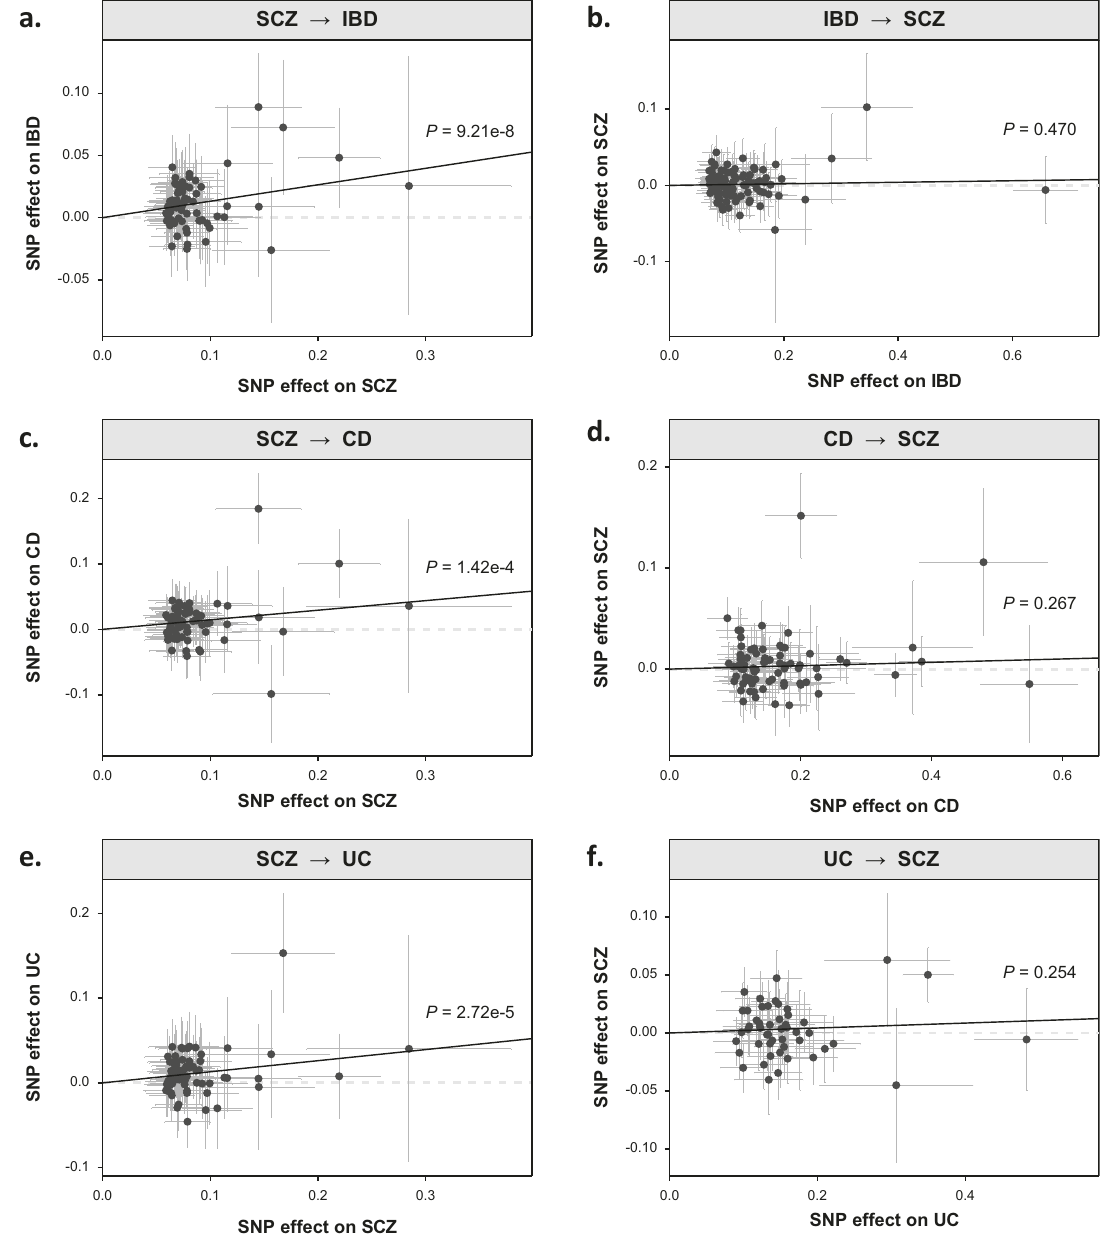
Fig. 1 Scatterplot of genetic associations between SCZ and IBD and its subtypes. Scatter plots show the MR-derived associations between genetically predicted ( a ) SCZ on IBD; b IBD on SCZ; c SCZ on CD; d CD on SCZ; e SCZ on UC; f UC on SCZ. SCZ: schizophrenia. Associations are calculated using the inverse-variance weighted method. SCZ Schizophrenia, IBD In fl ammatory bowel disease, CD Crohn ’ s disease, UC Ulcerative analysis. Third, the sensitivity analyses and pleiotropy tests conducted using multiple MR methods provided a robustness evaluation of the MR estimates. There were also limitations to this study. First, most of the participants in the included study samples were of European ancestry. This might limit the generalizability of the study fi ndings to other populations. In fact, the genetic architecture of SCZ in East Asian populations is very different from that in European